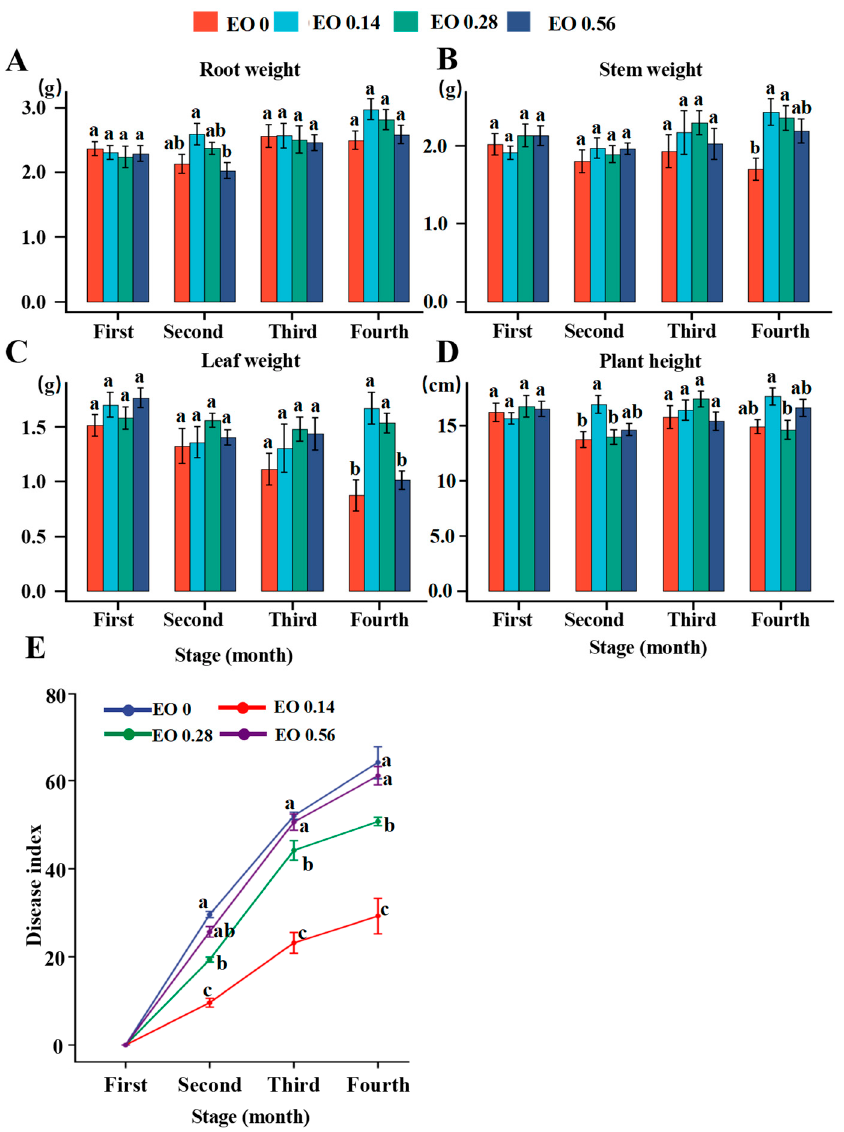
Figure 1. Root weight ( A ), stem weight ( B ), leaf weight ( C ), and plant height ( D ) in the four different essential oil (EO) levels at four stages. Error bars indicate the standard deviation of eight biological replicates. Different letters indicate significant differences ( p < 0.05) between the EO levels at each growth stage. ( E ) Disease index of P. notoginseng among the four growth stages. The four stages were EO treatment for one month, two months, three months, and four months. The concentrations of EO in the soil were 0 mg/g (control), 0.14 mg/g (low concentration), 0.28 mg/g (medium concentration), and 0.56 mg/g (high concentration). Different letters in each stage indicate statistically significant differences ( p < 0.05) according to ANOVA